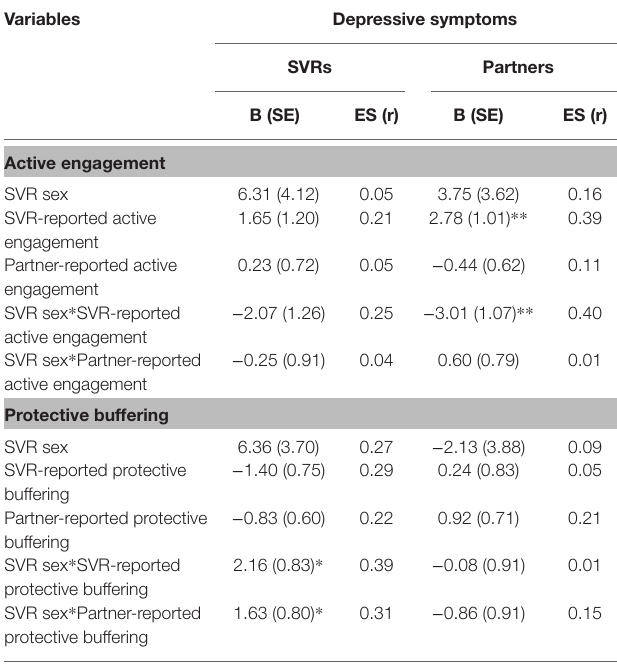
TABLE 5 | Moderating role of survivor sex on associations between active engagement and protective buffering and depressive symptoms ( n = 49 couples).